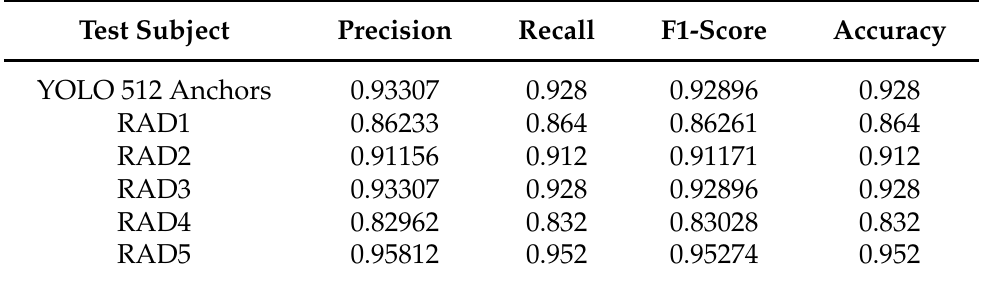
Table 6. Radiologist with AI—fracture-based evaluation on test set